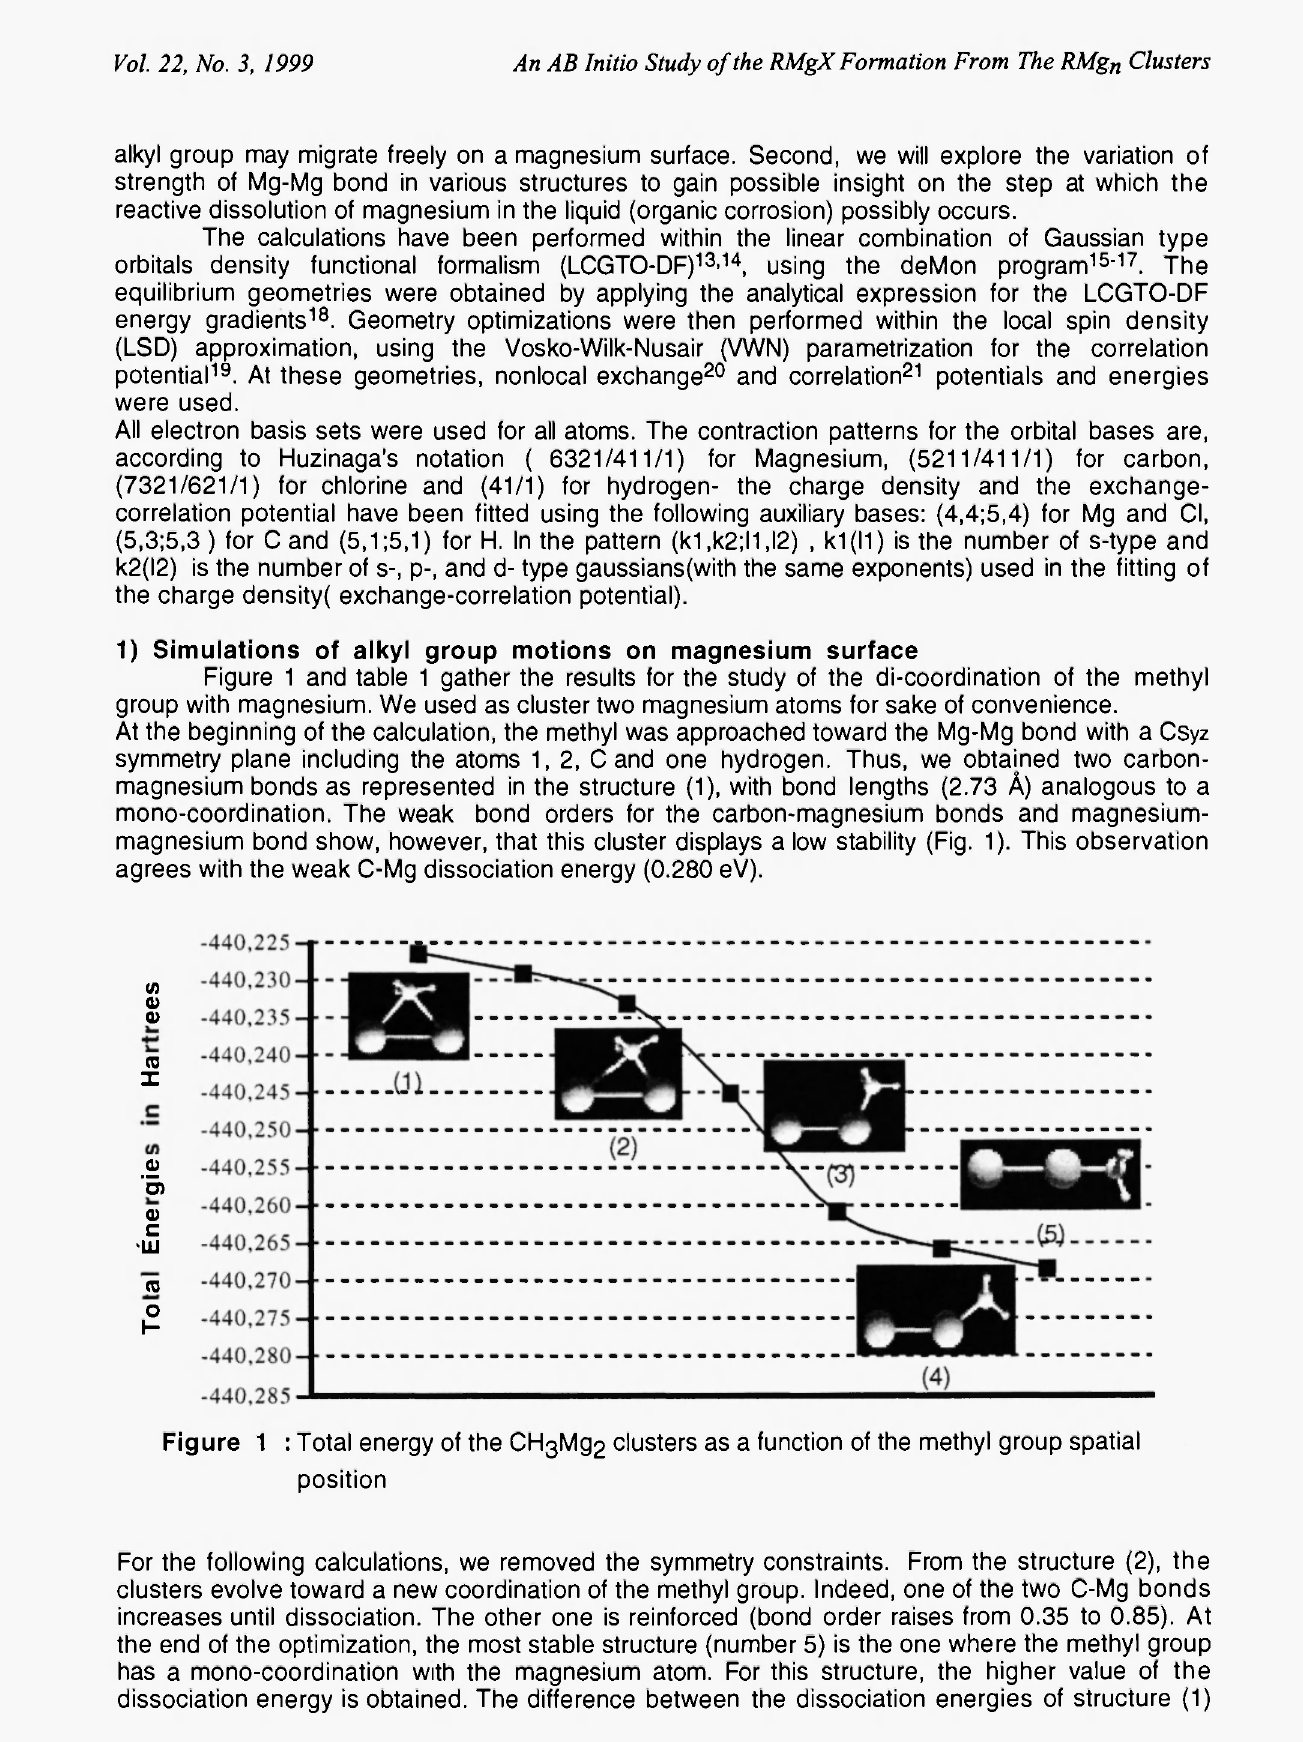
Figure 1 : Total energy of the CH3Mg2 clusters as a function of the methyl group spatial